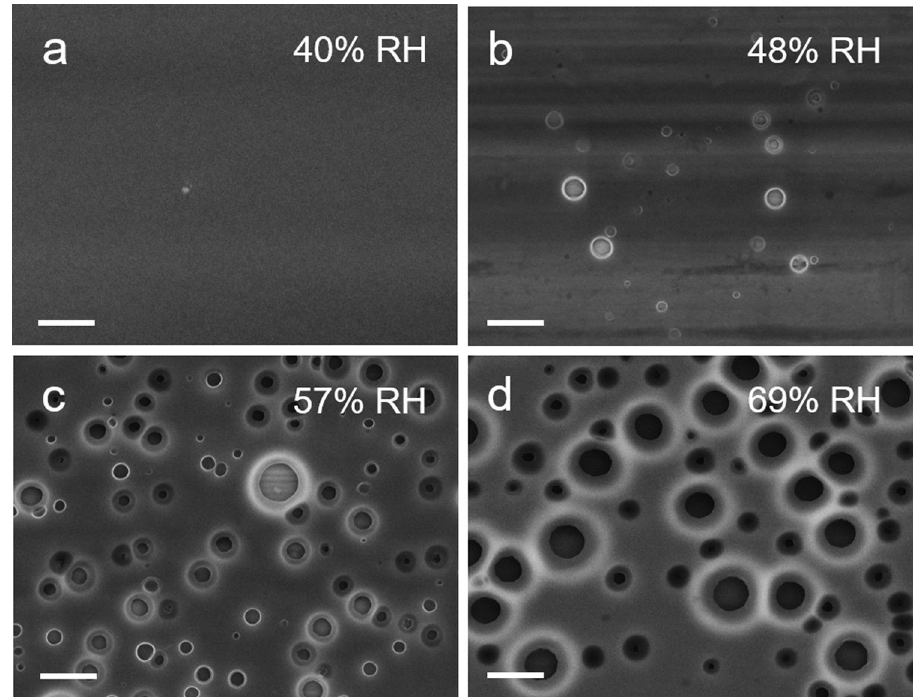
Fig. 4 Effect of humidity on fi lm morphology of the active layer. Film morphology of the PM6:Y6:PC 71 BM ternary active layer formed under different relative humidity of a 40%; b 48%; c 57%; and d 69%, respectively. The scale bar is 1 μ